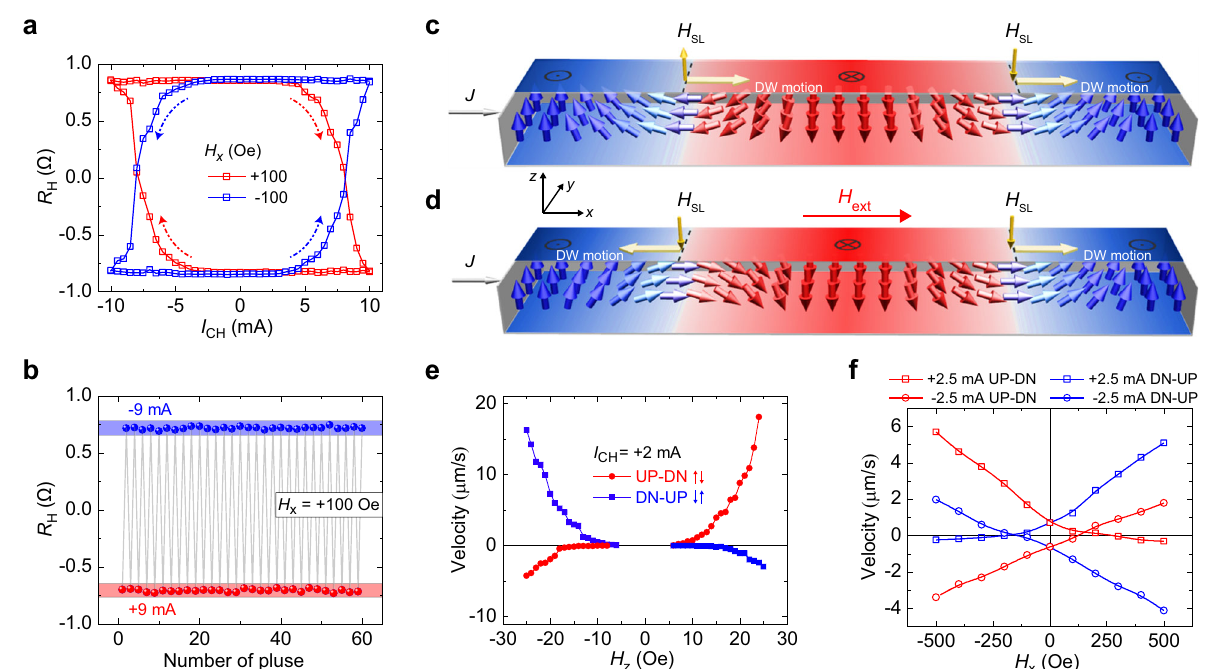
Fig. 2 Current-induced magnetization switching and chiral domain wall displacement. a Current-induced magnetization switching measured under H ¼ ± 100 Oe. The switching polarity is marked by the colored arrows. b Reversible magnetization switching induced by two opposite pulsed current of x ± 9mA at H x ¼ þ 100Oe. c The schematic illustration of the left-handed chiral Néel DWs without the application of in-plane magnetic fi eld, where the effective fi eld H associated with a Slonczewski-like torque drives adjacent up-to-down and down-to-up DWs moving towards the same direction with SL respect to the current. d The corresponding situation when a magnetic fi eld is applied along þ ^ x direction, where the left-handed up-to-down DWs changes into the right-handed up-to-down DWs, resulting a reversion of both the H SL and the DWs motion direction. e Up-to-down (abbreviated as UP-DN, red circles) and down-to-up (abbreviated as DN-UP, blue squares) domain wall velocity as a function of out-of-plane magnetic fi eld H z under I CH ¼ þ 2mA. f Domain wall velocity versus in-plane magnetic fi eld H x . Red and blue symbols represent up-to-down and down-to-up DWs, respectively. Square and circular symbols correspond to positive and negative currents,